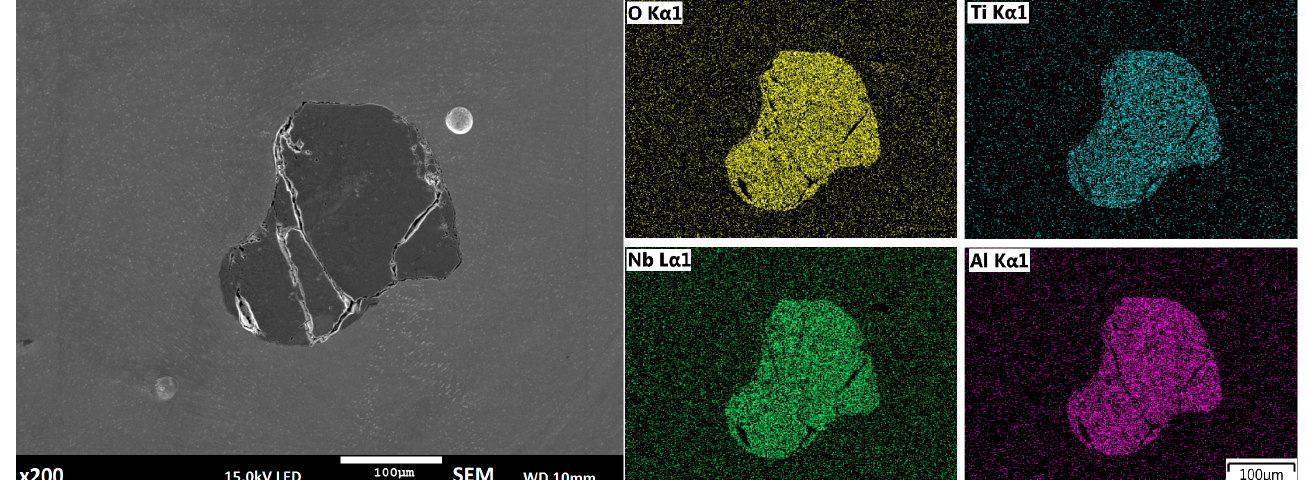
Figure 5. Defect alongside the fusion line, between the substrate and deposited layers in the wire deposition method. Defects occur in the material not only in the wire or powder deposition methods; some inclusions are identified in the developed semi-hybrid method as well. However, in this case, they are revealed in the buffer layer, and are related to the oxidation process (Figure 6); they are most probably (Ti,Nb,Al) x O y type oxides [28].